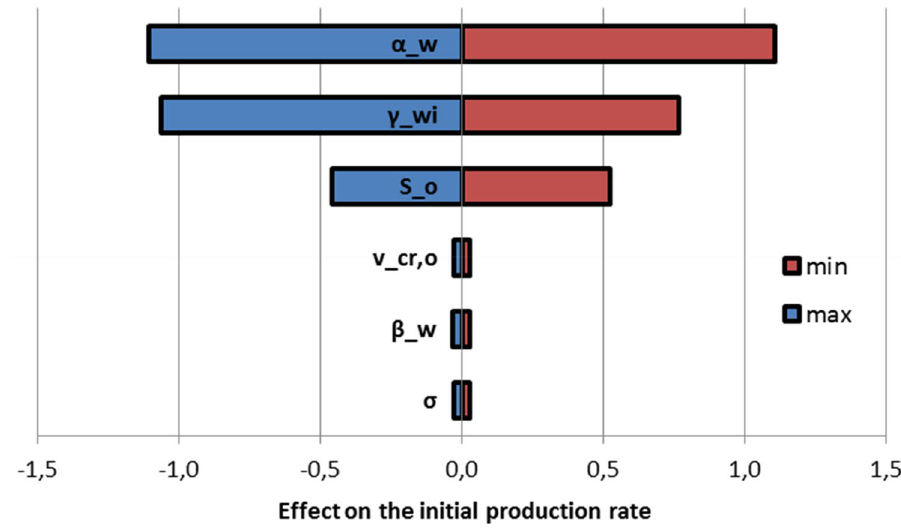
Fig. 14 Tornado diagram showing the effect of the input parameters on the initial pro- duction